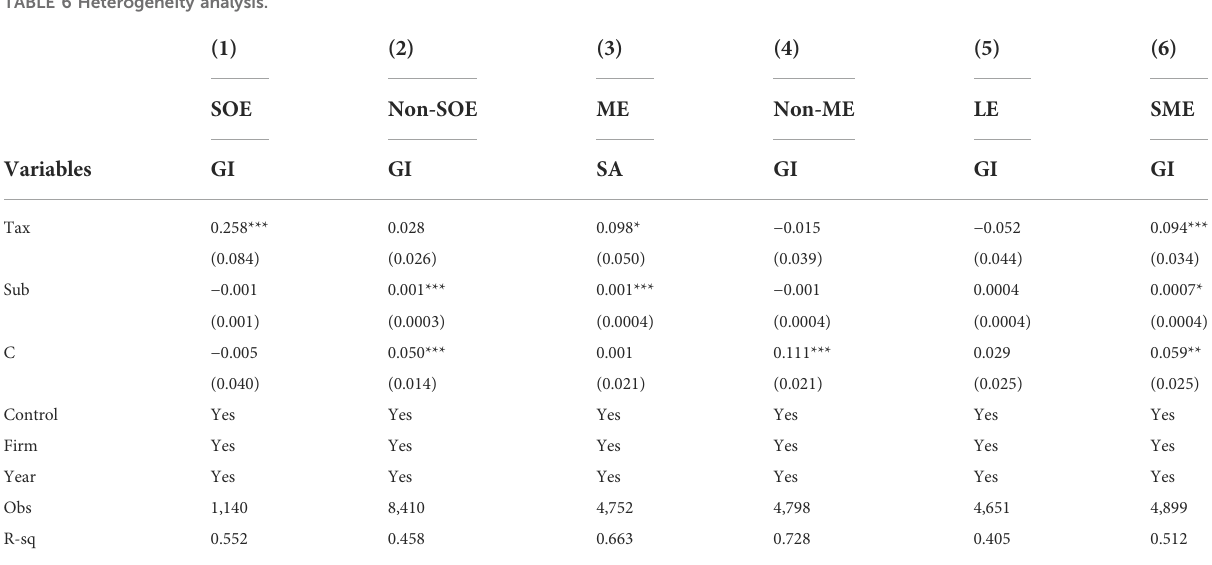
TABLE 6 Heterogeneity